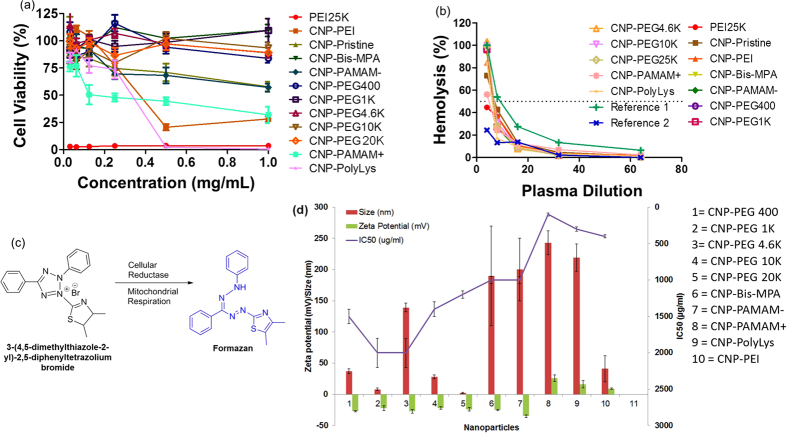
Cellular and systemic toxicity evaluated by MTT and CH 50 assays.(a) The cytotoxic effects on C32 human melanoma cells after incubation of PEI and CNPs for 48 hr. (b) Immunotoxic assessment of complement activation resulted from 4, 8, 16, 32 and 64 times dilutions of swine plasma. (c) Change in chemistry of 3-(4,5-dimethylthiazole-2-yl)-2,5-diphenyltetrazolium bromide after cellular reduction in living cells. Formazan concentration correlates with viable cell population among treated pool of cells. (d) Comparative evaluation of IC50 values related to hydrodynamic diameters and surface zeta potential of various nanoparticles.